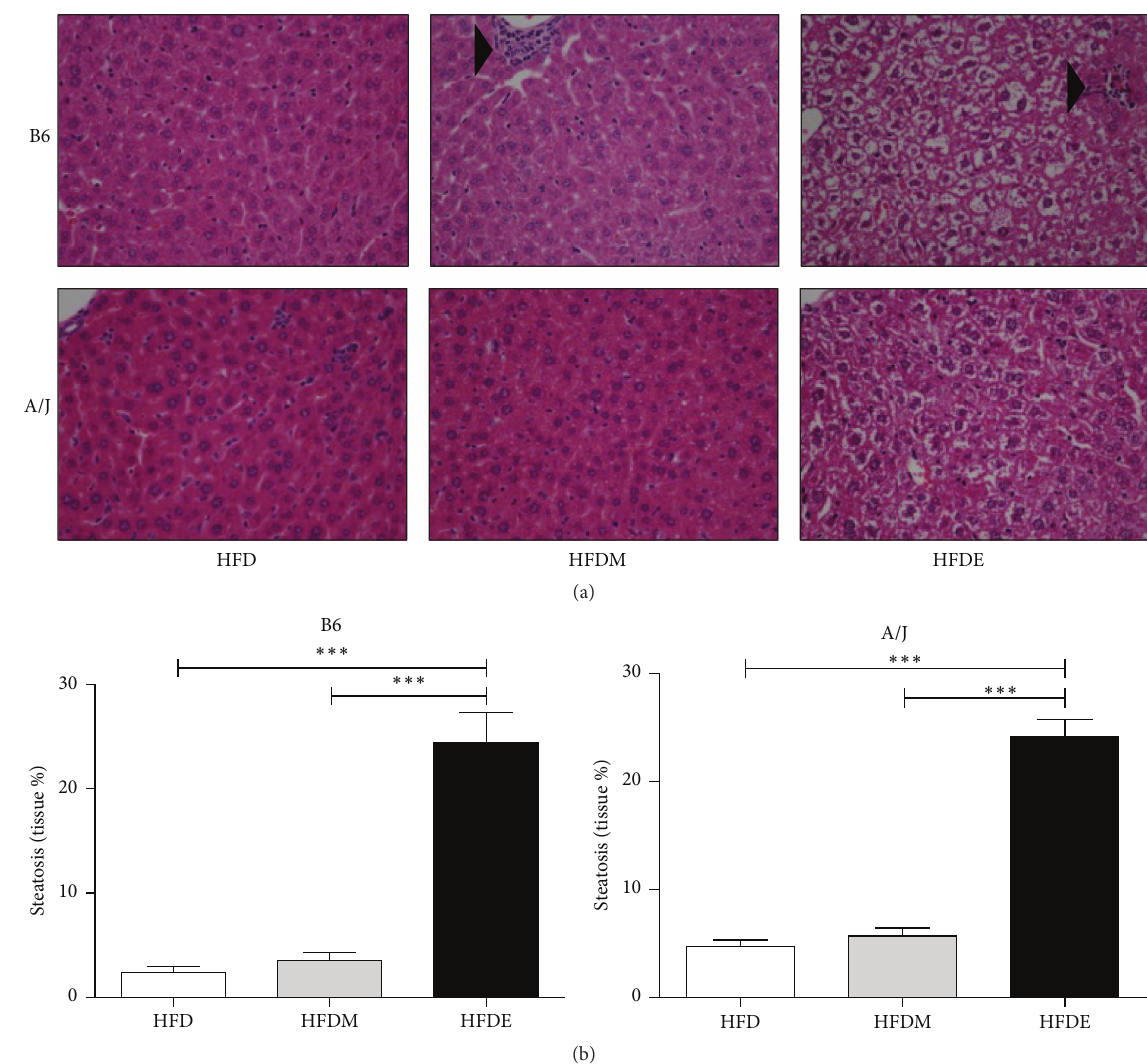
Figure 2: Liver alterations in B6 and A/J mice supplemented with ethanol. Liver sections were obtained from B6 and A/J mice fed with HFD, HFDM, or HFDE for 10 weeks. Liver sections were formalin-fixed and paraffin-embedded before HE staining. Arrowheads point to inflammatory cell infiltrates (magnification 40x) (a). Ten random fields of each slide at magnification of 40x were photographed and the percentage of steatosis was measured using the Image J program (b). Eight- to ten-week-old male mice were used in all experiments ( 𝑛 ≥ 5 ). HFD: high fat diet, HFDM: HFD containing maltodextrin, HFDE: HFD containing